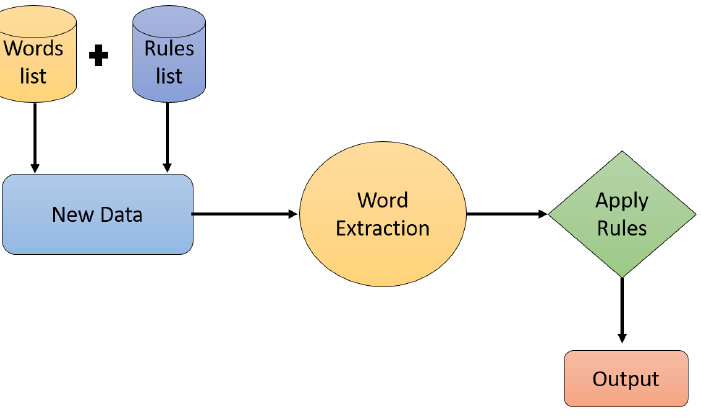
Figure 9. Architecture of Lexicon based